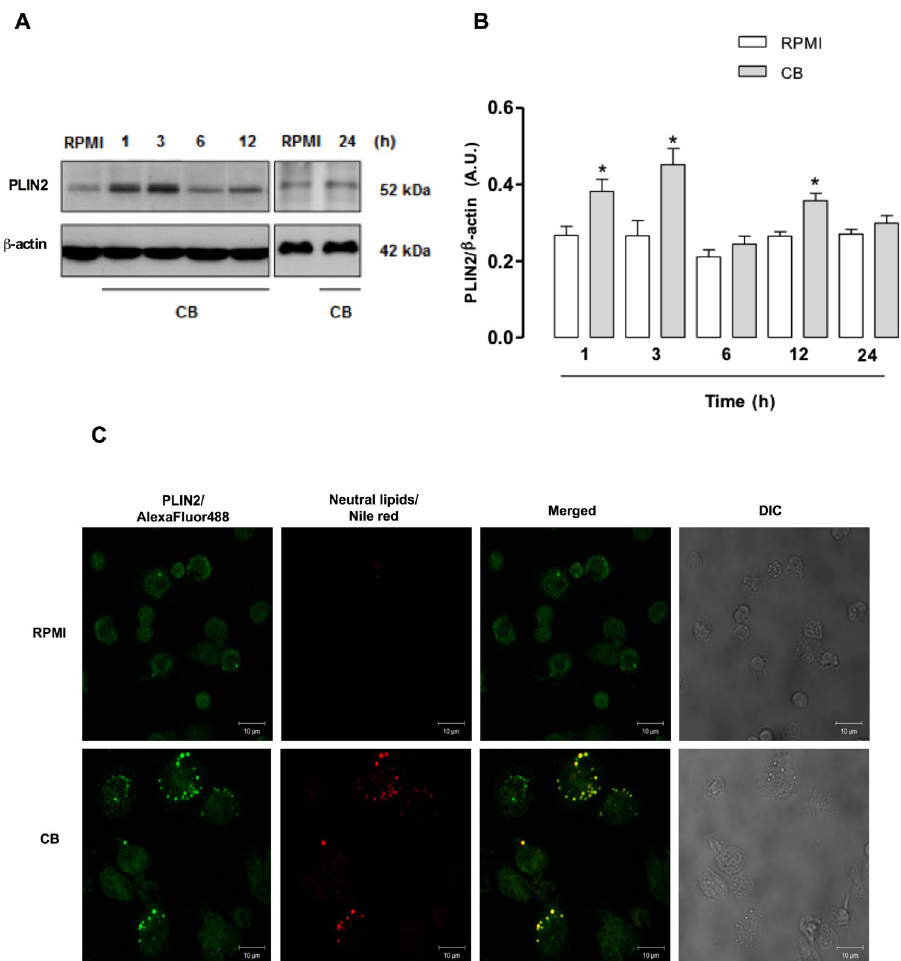
Figure 2. CB up- regulates PLIN2 protein expression in macrophages. Peritoneal macrophages were incubated with CB (0.4 µ M) or RPMI (control) for 1, 3, 6, 12 and 24 h. ( A ) Western blotting of PLIN2 and β -actin (loading control) in macrophage extracts. Immunoreactive bands of 24 h were obtained in a distinct assay. ( B ) Densitometric analysis of PLIN2 bands. The densities (in arbitrary units) were normalized with those of β -actin. Results are expressed as mean ± SEM for three experiments. * p < 0.05 compared with RPMI. Blots were cropped and full-length blots can be found as Supplementary Figure S1. ( C ) Macrophages were incubated with RPMI (control) or CB (0.4 µ M) for 3 h and labeled for LDs (with Nile Red) and for PLIN2 (with FITC- conjugated antibody). The merged image shows colocalization of PLIN2 to LDs. The pictures are representative of three independent